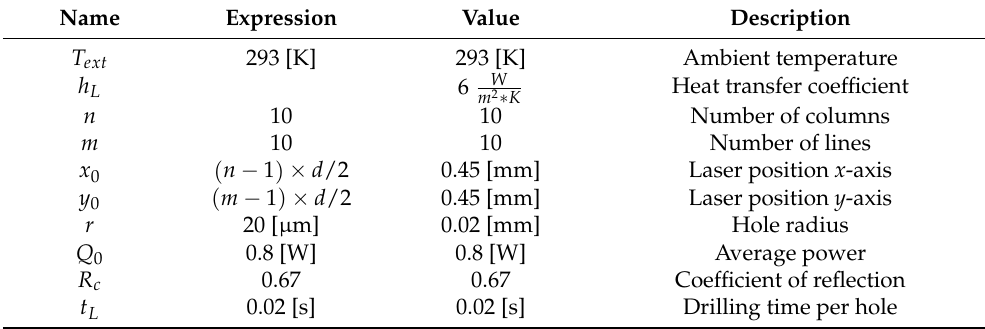
Table 2. The parameters of the heat simulation in COMSOL Multiphysics of a 10 × 10